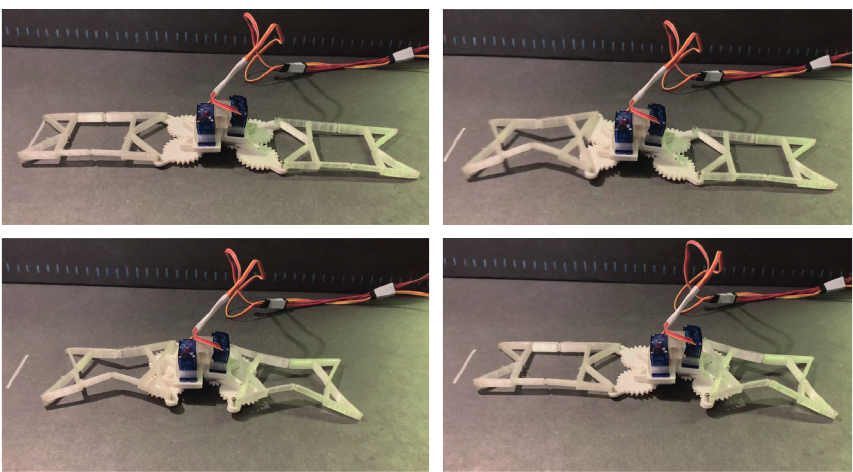
Figure 14: Robot movement: step contractions that generate a displacement of millimeters.